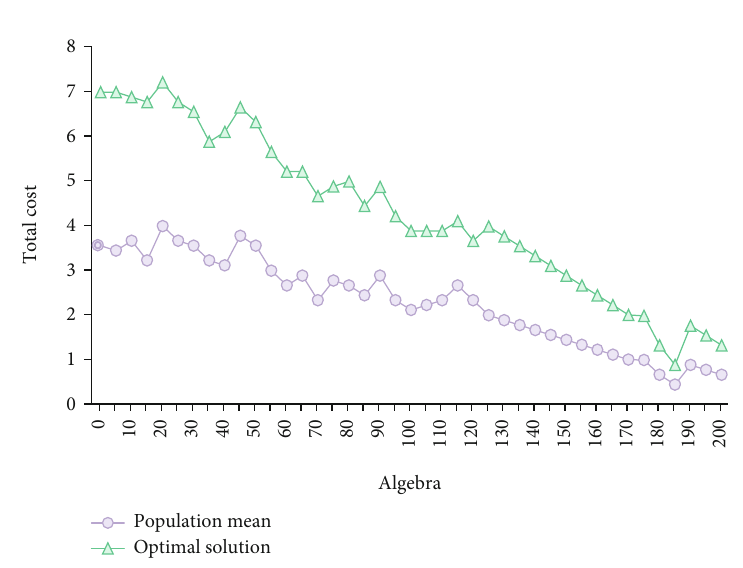
Figure 8: Iterative diagram of genetic